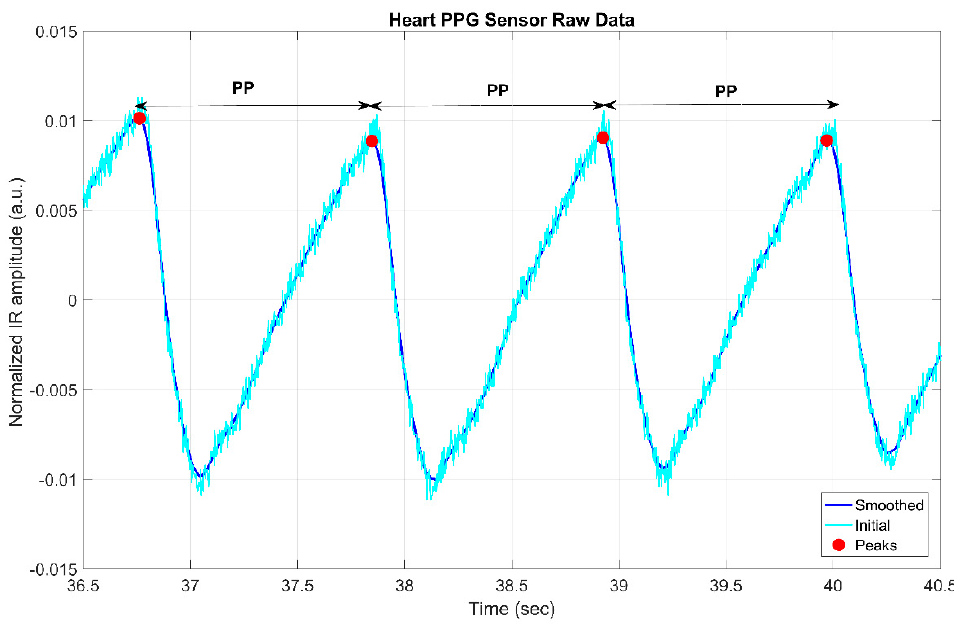
Figure 5. Captured PPG signal (healthy male, 34 years of age).